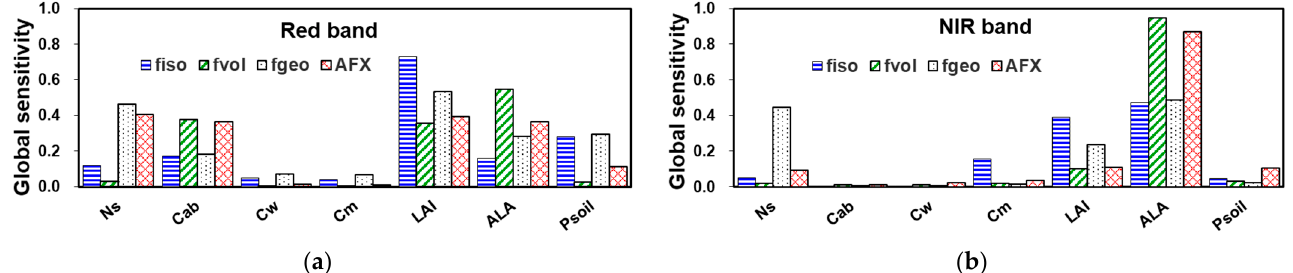
Figure 3. Global sensitivity of the BRDF variables to the vegetation parameters: ( a ) red band; ( b ) NIR band.